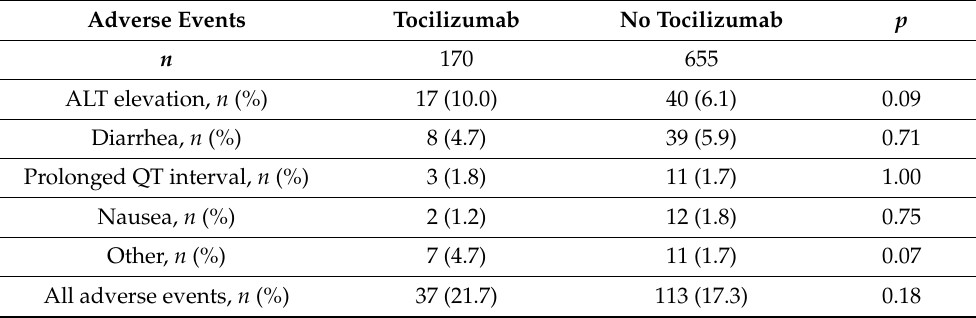
Table 5. Prevalence of adverse